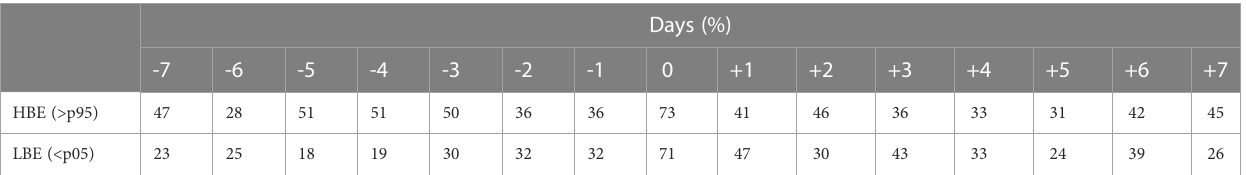
TABLE 3 Mean spatial availability of sea surface satellite data at 1km horizontal resolution within the southern part of the Inner Sea of Chiloe ́ (S-ISC, i.e. % of gridpoints with valid data) around high biomass events (HBE, i.e., days for which the mean spatial nFLH ’ signal is above the p95 threshold) and low biomass events (LBE, i.e., days for which the mean spatial nFLH ’ signal is blow the p05